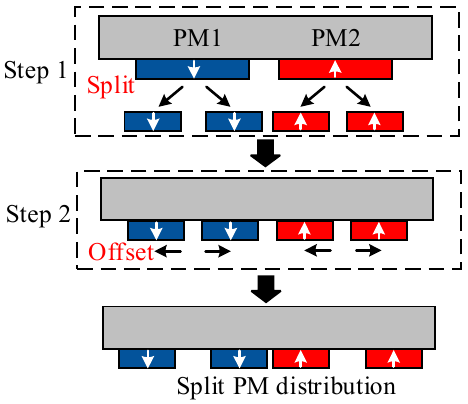
Figure 2. The PM topology transformation process.